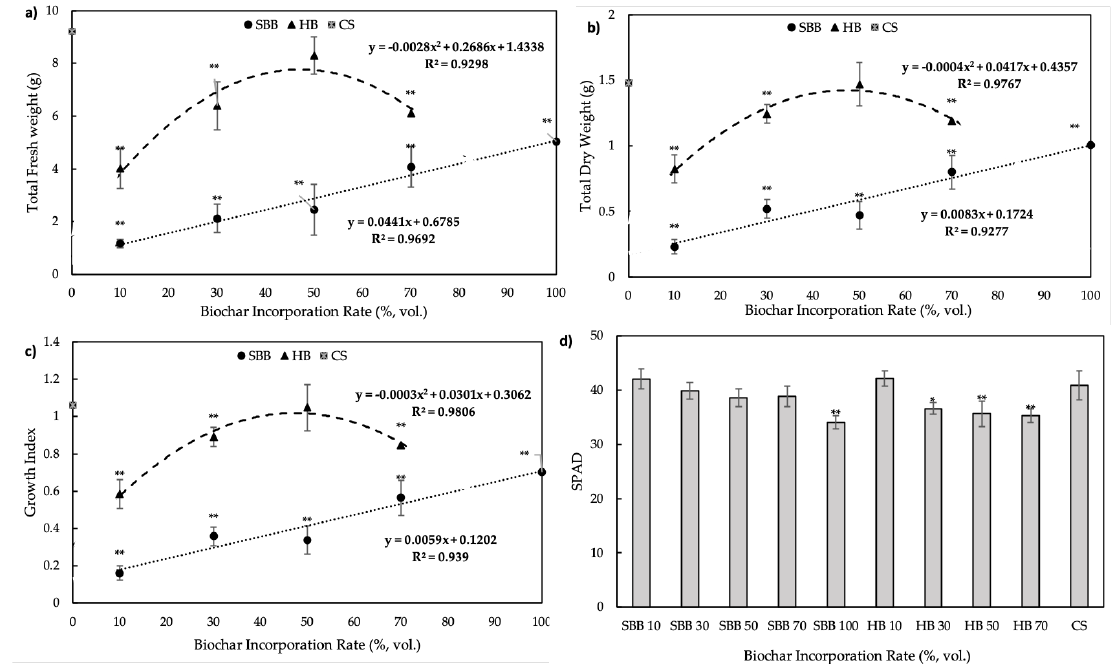
Figure 4. The correlations between total fresh weight (TFW, a) , total dry weight (TDW, b) , growth index (GI, c) and biochar incorporation rate and the soil-Plant Analyses development (SPAD) (d) of tomato seedlings grown in biochar-amended mixes. SBB = sugarcane bagasse biochar; HB = mixed hardwood biochar; CS = commercial propagation substrate. SBB (10%, 30%, 50%, 70% and 100%; by vol.) incorporated with 30% perlite with the rest being peat moss; HB (10%, 30%, 50% and 70%; by vol.)